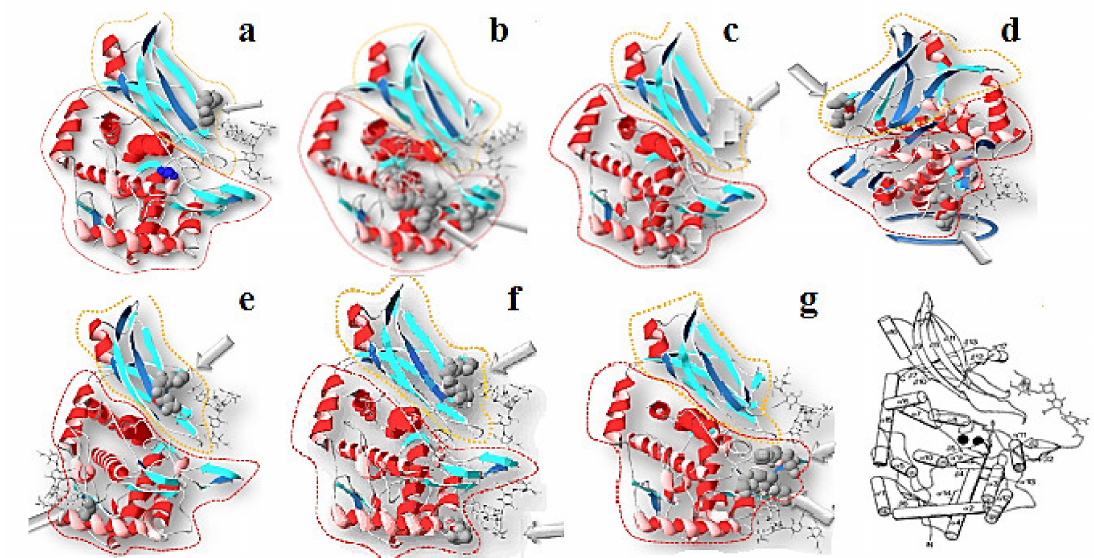
Figure 15. 3D-models of FU from «a“ to «g“ of HtH1 and potential N -linked sites, depicted on the basis of the structure of OdH-g. β -sandwich domain (yellow); α -nucleus (red); N -glycolised site (grey). The glycans are marked with arrows